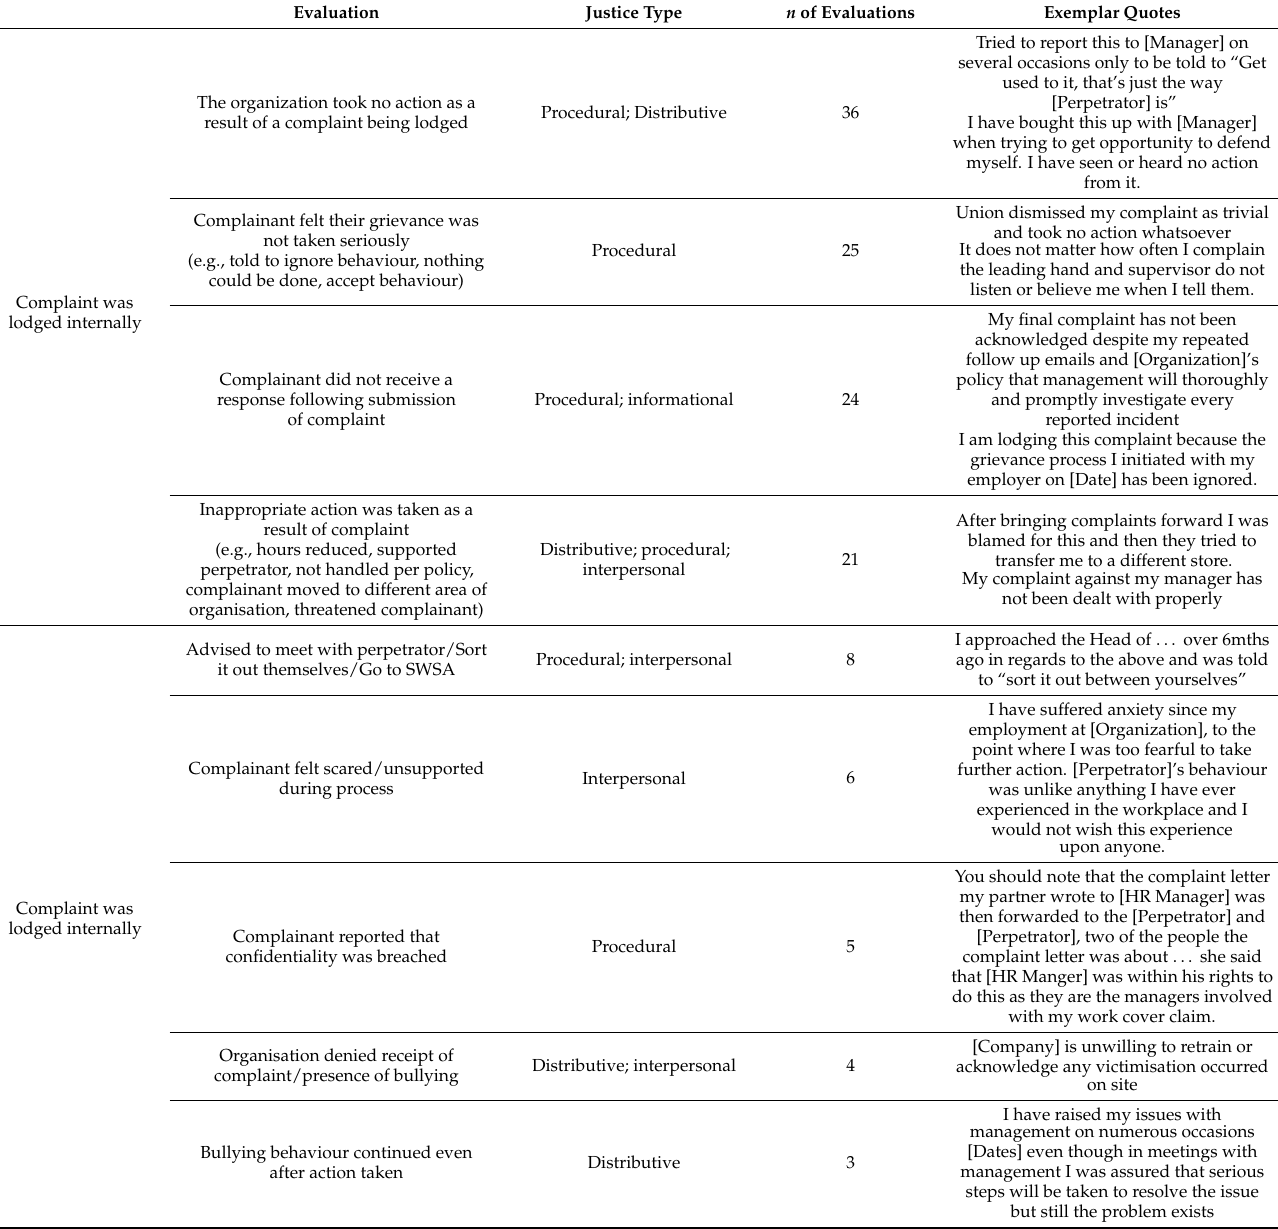
Table 6 overviews (in detail) the manifestation of organizational justice in workplace bullying complaints process. Procedural justice was regularly threatened where due pro- cess was not followed, i.e., where there was no response or action from the organization following submission of the complaint (which also triggered perceptions of poor distribu- tive justice), where the complaint was not properly acknowledged or escalated, where there was perceived pressure to withdraw the complaint, and when confidentiality of the complaint process was breached. Similarly, a lack of support from the organization activated perceptions of diminished interpersonal justice, stemming from perceived pres- sure to withdraw the complaint and/or accept inappropriate actions resulting from the complaint process. We explored the potential for a relationship between perceptions of organisational justice manifestation to perpetrator type and to investigator role but did not observe any significant associations. Table 6. Triggers of Justice Reactions in the Internal Complaint